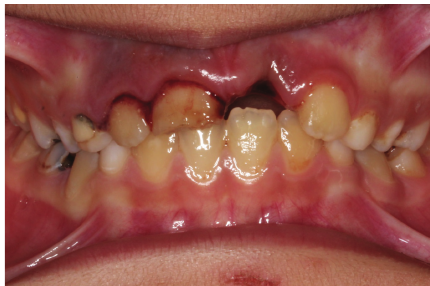
Figure 1: Avulsion of the left upper incisor.